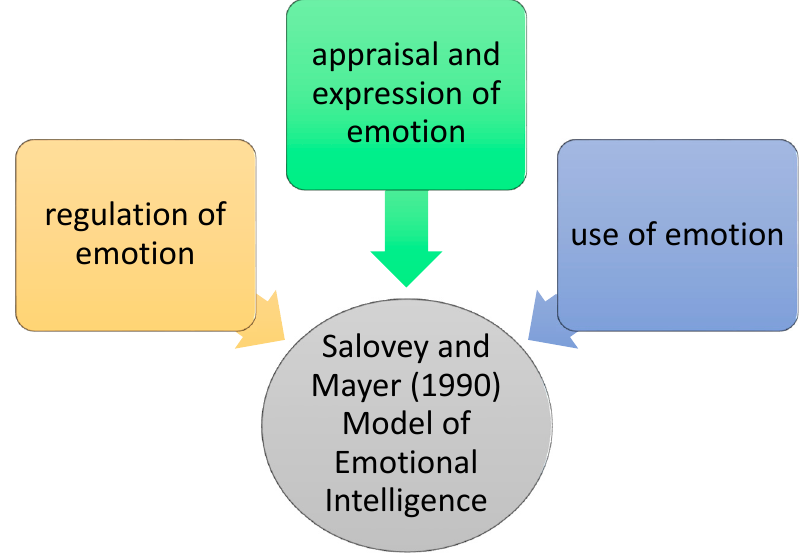
Figure 1. The Salovey and Mayer (1990) model of emotional intelligence (Adapted from Perez et al. 2004).